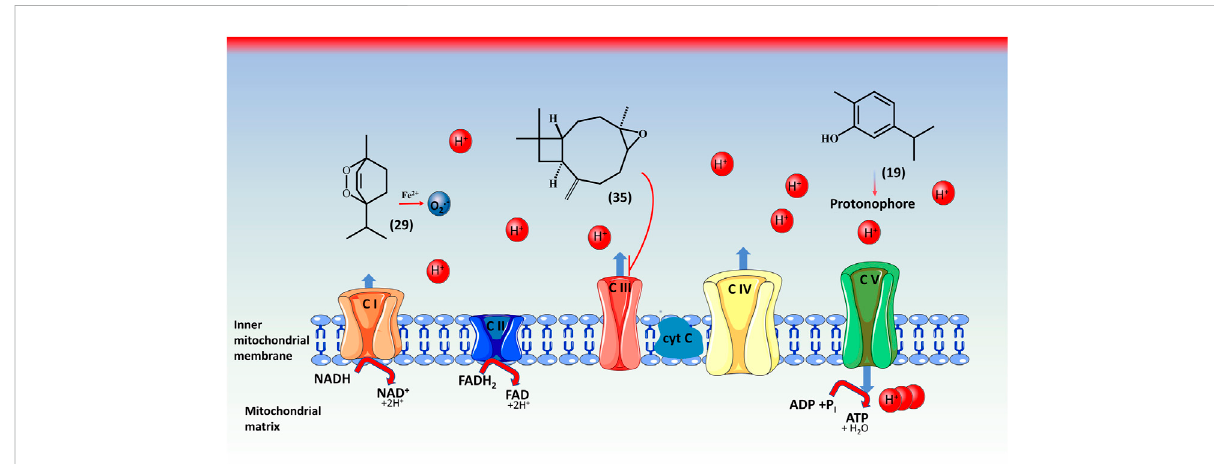
FIGURE 5 Toxicity mechanisms of ascaridole (29) , carvacrol (19) , and caryophyllene oxide (35) in mitochondria. Both oxidative stress and mitochondrial dysfunction are employed in the mechanism of toxicity by the Dysphani a ’ s EO. The EO have inhibitory effects on mitochondria ’ s ETC (electron transport chain) complex I-III. Caryophyllene oxide (35) carries out inhibition on complex III (CIII). Ascardiole (29) following activation by iron (Fe 2+ ) threatens mitochondrial uncoupling and triggers superoxide radical formation (O 2 .- ). Carvacrol (19) has no direct inhibiting effects, but a synergistic effect with ascaridole. *complex I: NADH ubiquinone oxidoreductase; complex II: succinate ubiquinone oxidoreductase; complex III: ubiquinol cytochrome c oxidoreductase; complex IV: cytochrome C oxidase; complex V: F 1 F 0 ATP synthase. NADH, nicotinamide